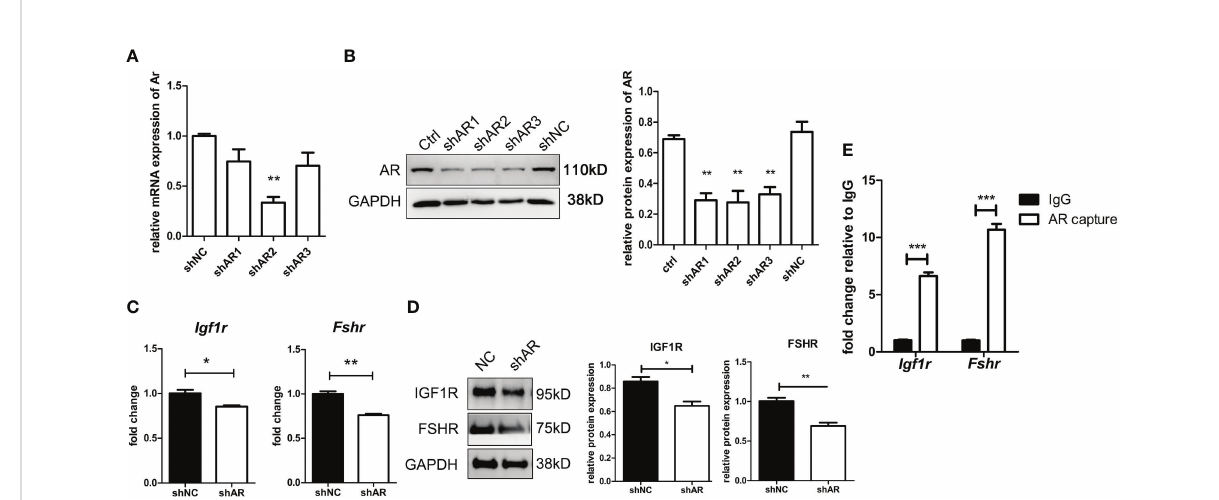
FIGURE 8 AR directly stimulates IGF1R and FSHR expression by binding to the promoter regions of IGF1R and FSHR. KGN cells were transfected by three shAR vectors. The ef fi ciency of knockdown was tested by qPCR (A) and Western blot (B) . n = 3; t-test comparison between the control group and other groups. shAR2 was used for further experiments, and the transfected cells were collected to determine the mRNA expression (C) and protein expression (D) of IGF1R and FSHR. n = 3; t-test. KGN cells were treated with DHT for 1 h followed by the ChIP assay. AR antibody-enriched DNA fragments were detected for promoter sequences of IGF1R and FSHR by qPCR. n = 3; t-test. (E) *P < 0.05; **P < 0.01; ***P <